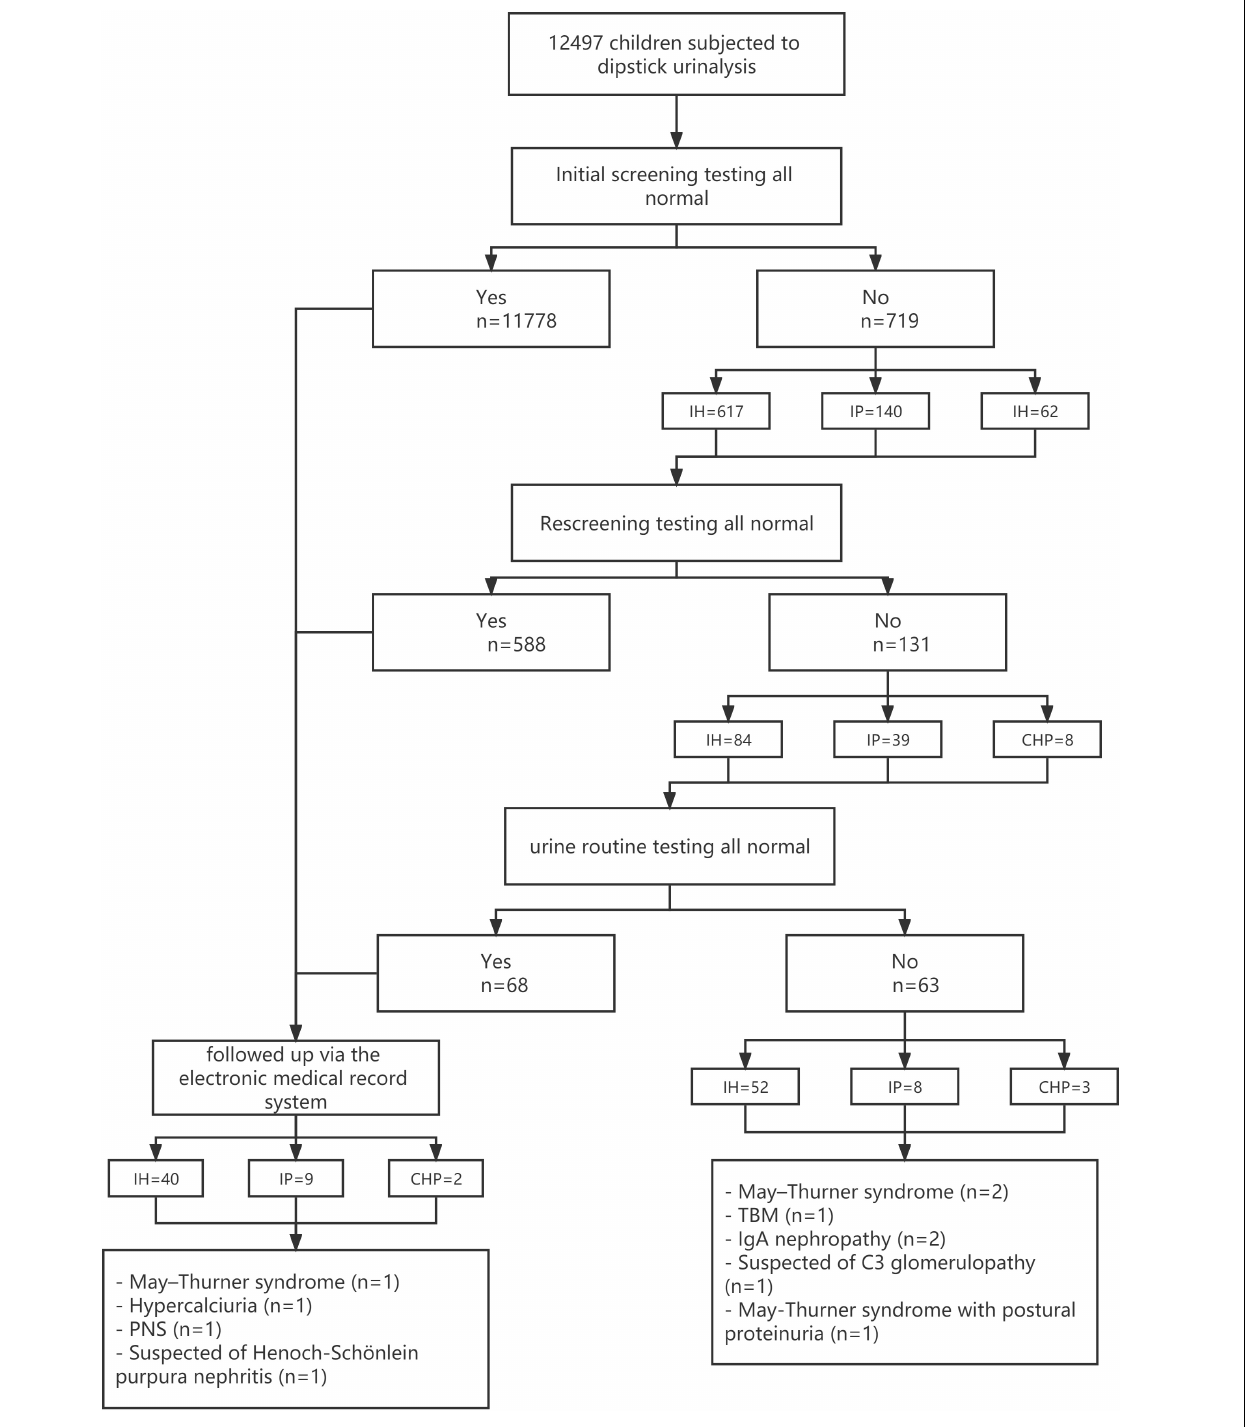
FIGURE 1 | Screening of primary and secondary school children and their follow-up.